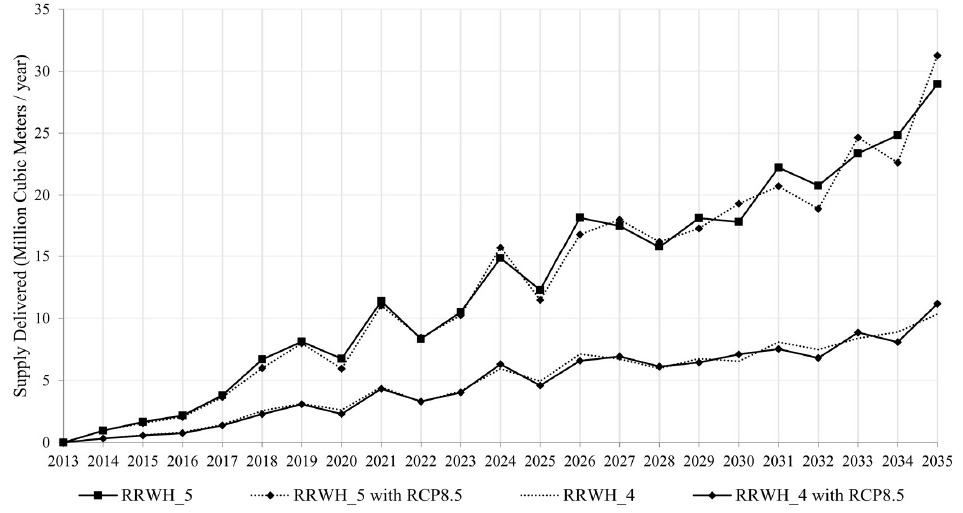
Figure 12. Effect of climate change on the RRWH_4 and RRWH_5 scenarios.